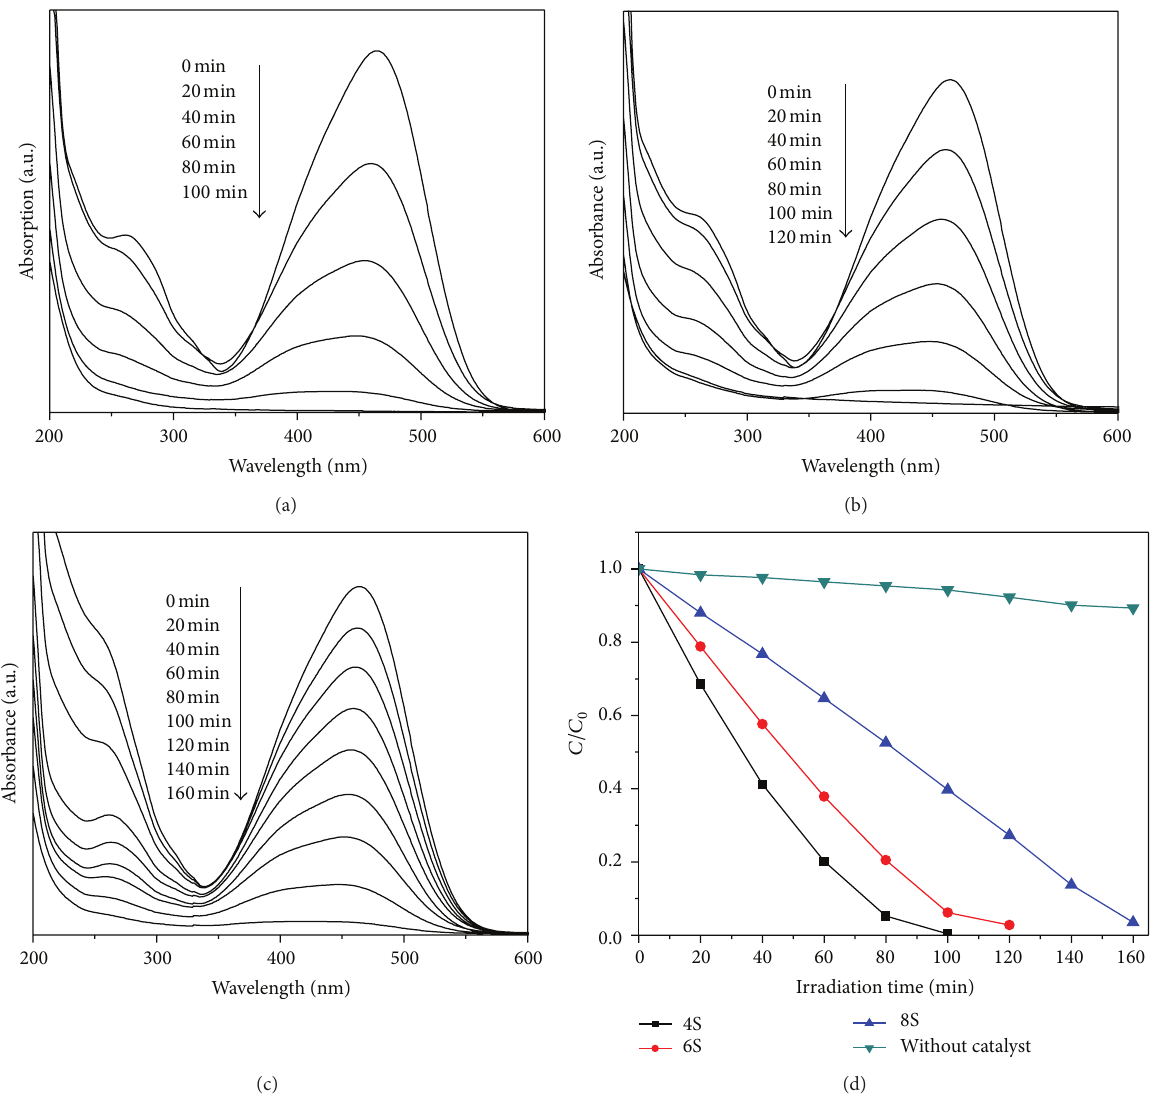
Figure 5: Temporal evolution of MO absorption spectra under irradiation of UV-light by using as-prepared Zn 2 SnO 4 as photocatalyst: (a) 4S, (b) 6S, and (c) 8S; (d) photodegradation of MO as a function of irradiation time, in which 𝐶 is the concentration of MO and 𝐶 0 is the initial